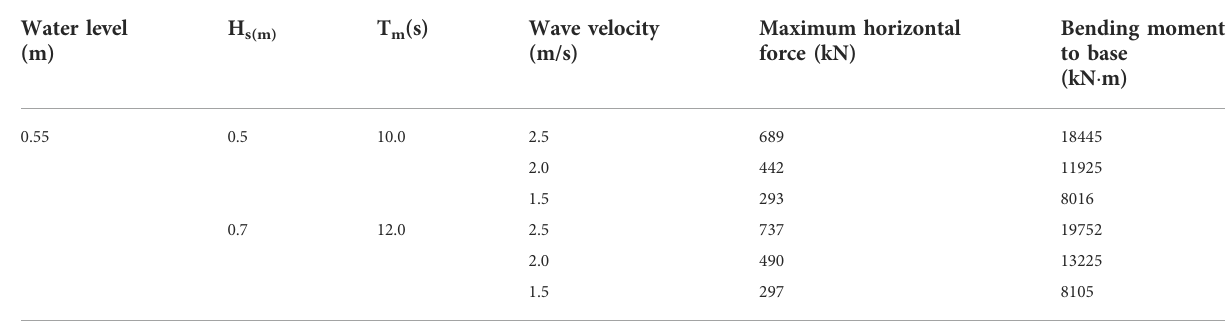
TABLE 4 Test results of wave and current forces of 22# Pier.